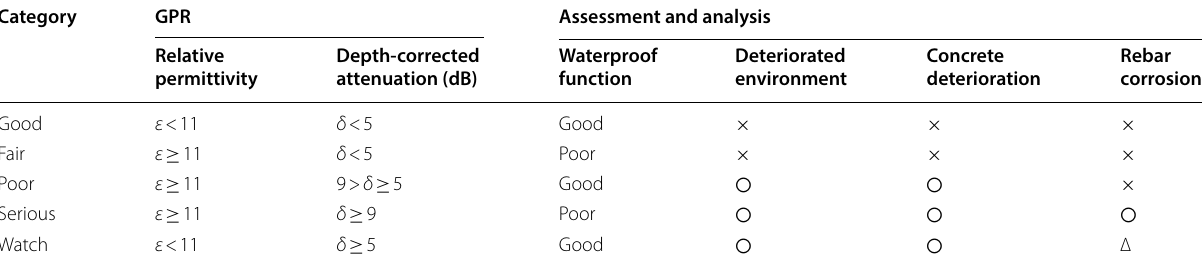
Table 6 Dual-criteria based GPR interpretation for condition assessment of concrete bridge decks with asphalt overlays in Korea expressway